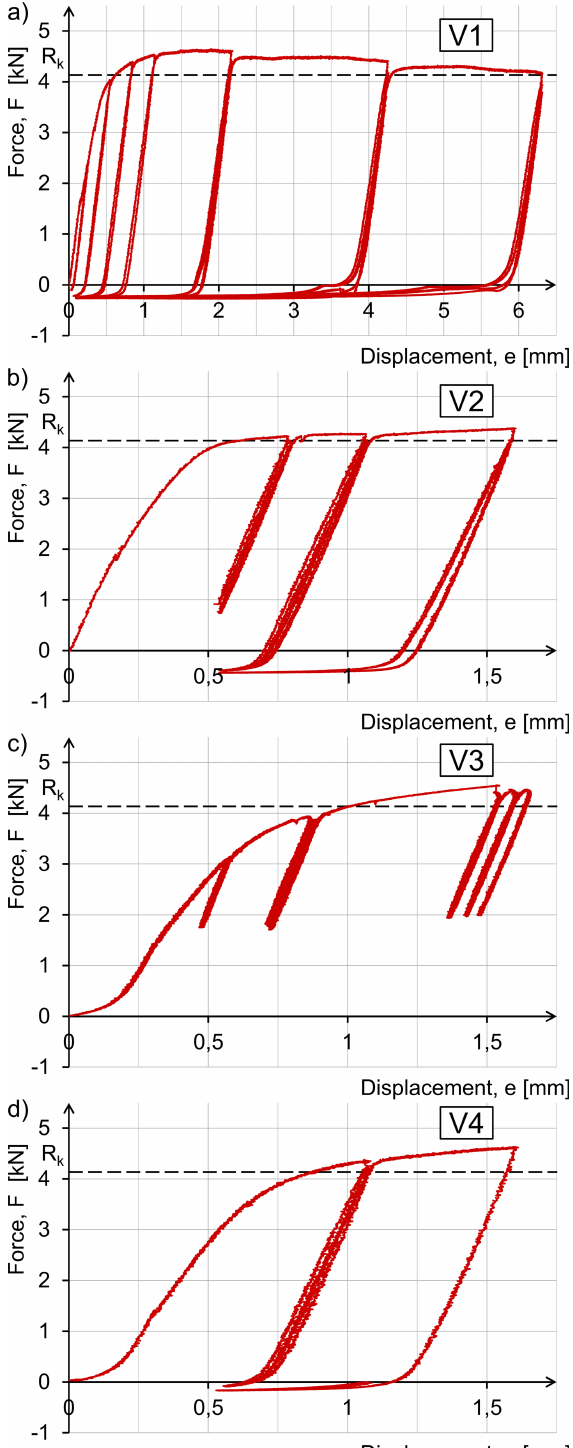
Figure 7: Load-deformation response of the S2 group under variable loading histories: a) cyclic according to ECCS; b) repeated with displacement control, c) repeated with force control, d) repeated with